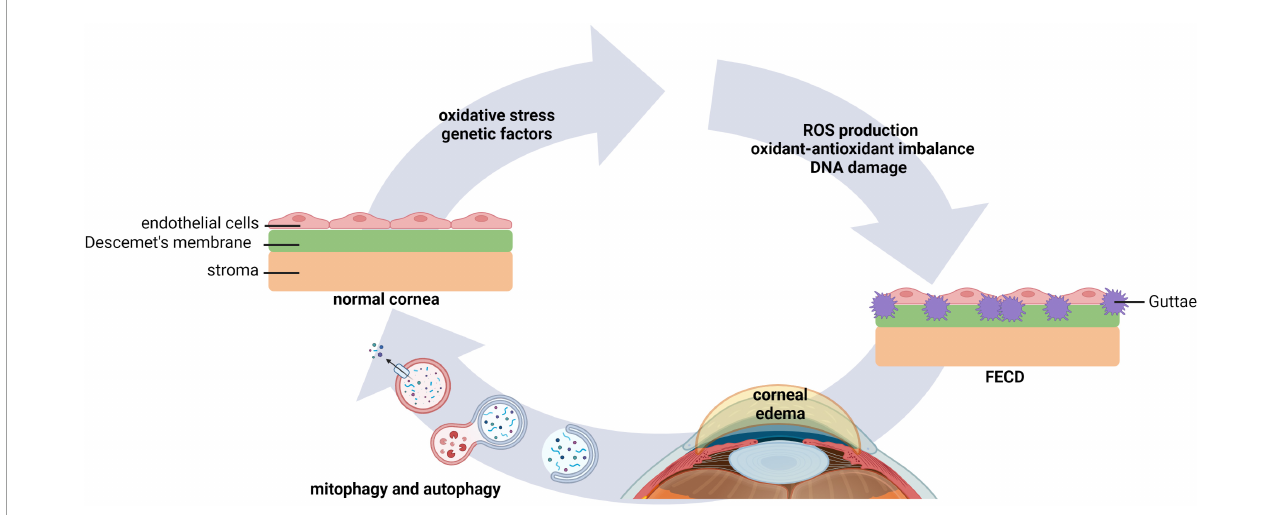
FIGURE4 Autophagy and mitophagy play key roles in FECD. Environmental factors that lead to oxidative stress, as well as genetic factors, underlie morphological changes in corneal endothelial cells. This leads to an increase in ROS production, oxidant-antioxidant impairments, mitochondrial fragmentation, and DNA damage. Extracellular matrix excrescences form in Descemet’s membrane. Dysregulated pump function in the compromised corneal endothelium causes stromal edema and vision loss. Evidence suggests that modulation of mitophagy and autophagy may improve corneal homeostasis in FECD. FECD, Fuchs endothelial corneal